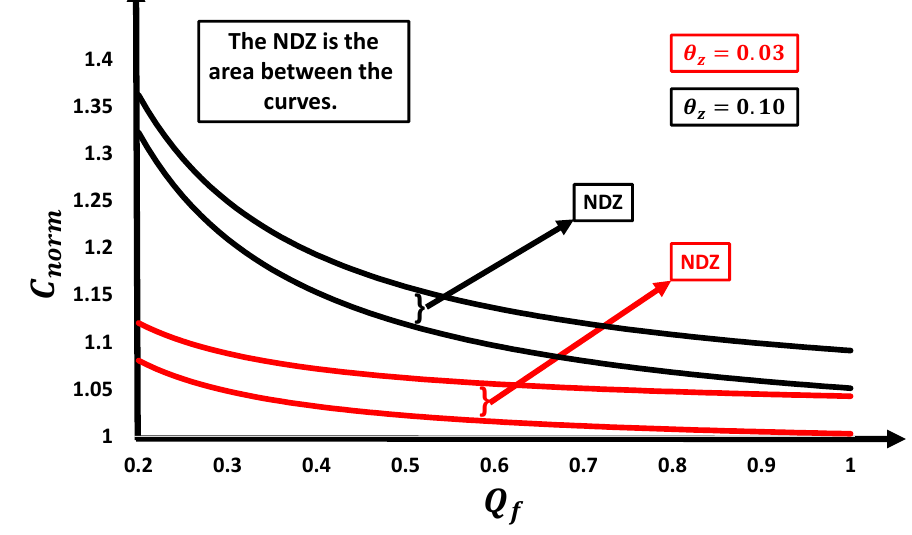
Figure 8. NDZ of the AFD proposed by [24].